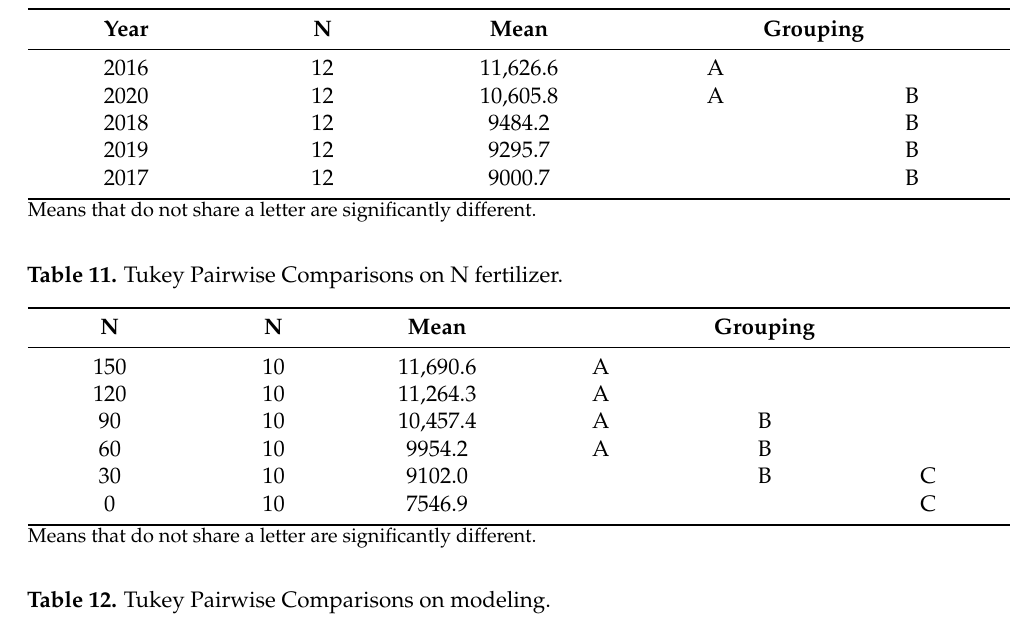
Table 10. Tukey Pairwise Comparisons on years.